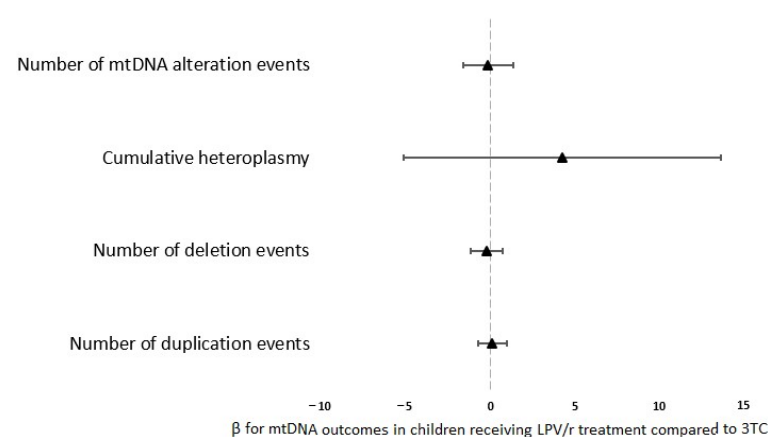
3.4. Impact of the Prophylactic Drug Exposure on mtDNA Instability At W50, children exposed from D7 to W50 to either the LPV/r or 3TC drug had a comparable number and quantity of mtDNA alteration events (Figure 2). comparable number and quantity of mtDNA alteration events (Figure 2).